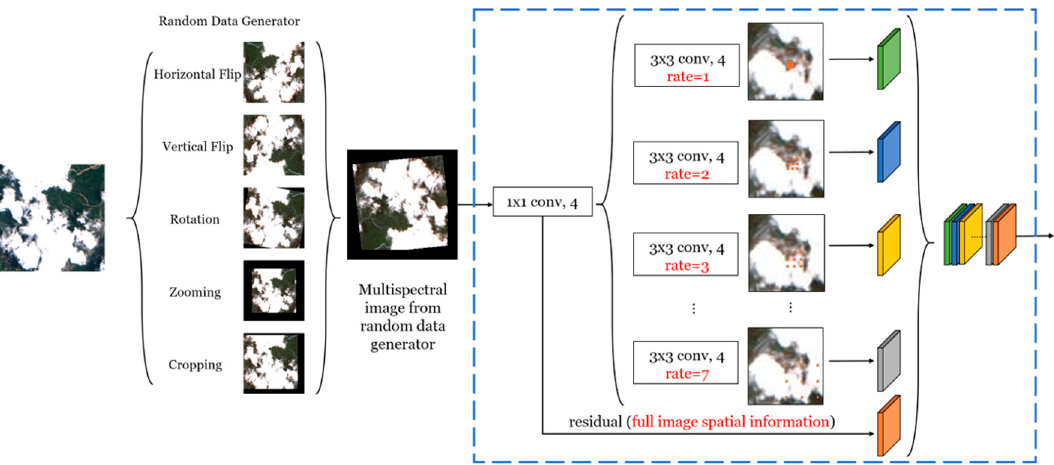
Figure 8. Illustration of the training unit of CloudNet (shown as the blue dotted line in Figure 7).